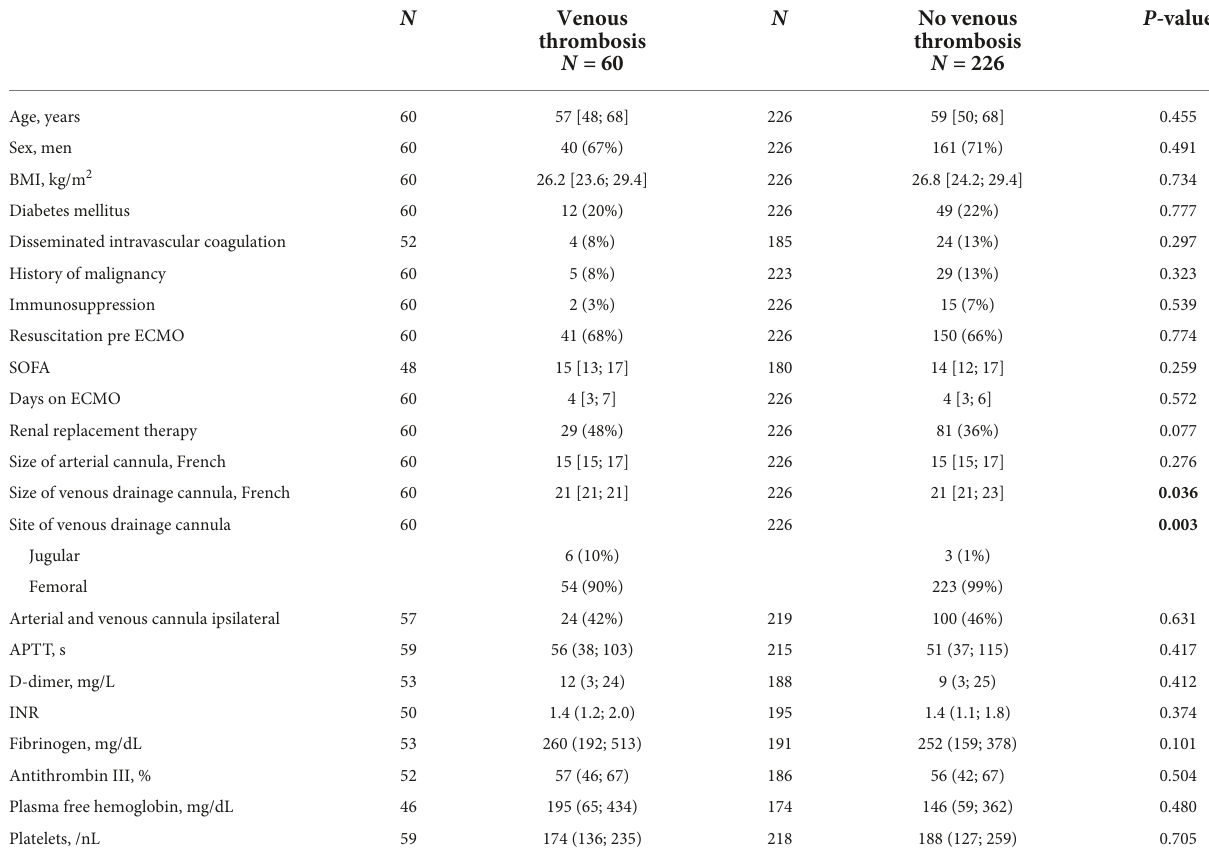
TABLE 1 Patient characteristics at cannulation with regard to venous